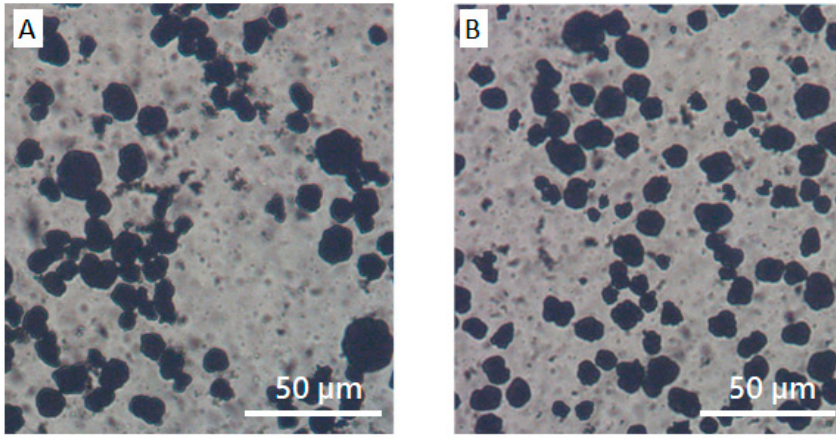
Figure 10. Microscope images of ( A ) NCM/CB/NMP and ( B ) NCM/CB/PVP/NMP.